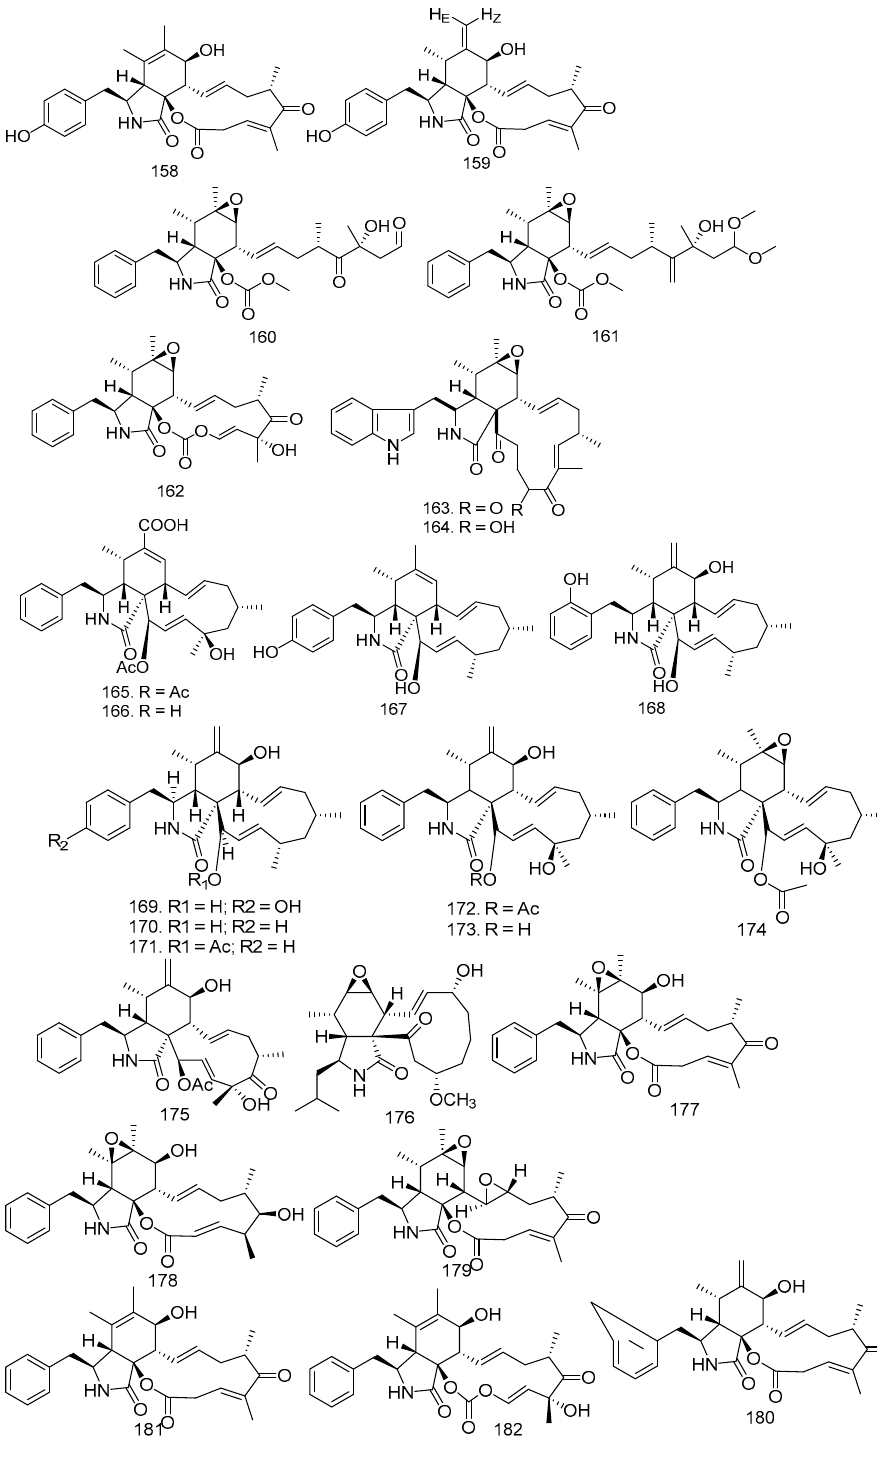
Figure 9. All of the cytochalasin structures obtained from endophytic fungi in Meliaceae.